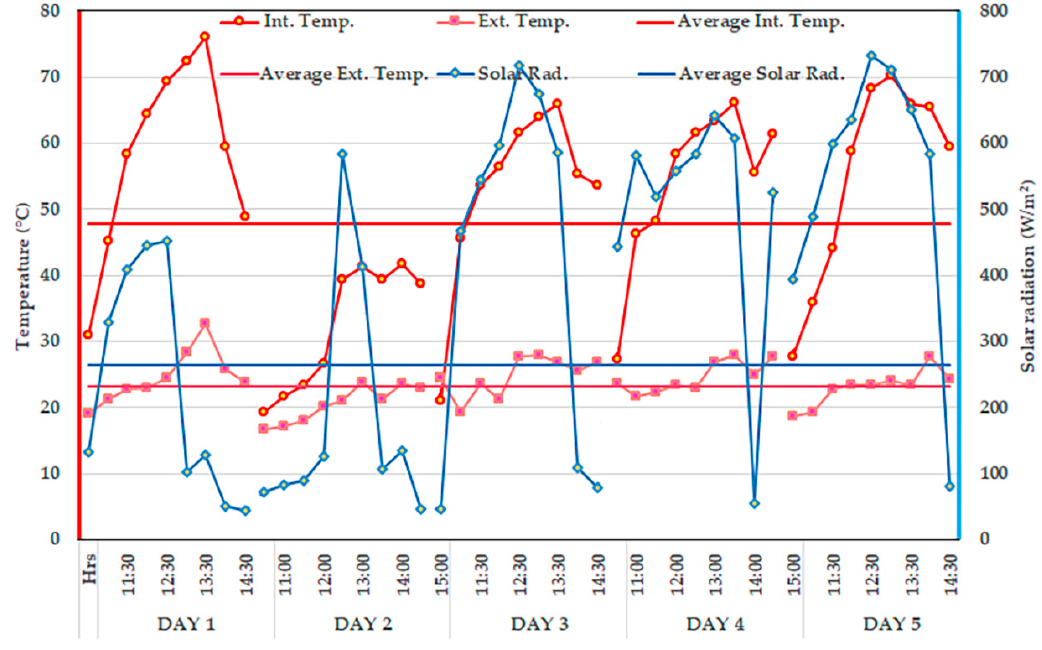
Figure 2. Environmental conditions of the brick drying process.